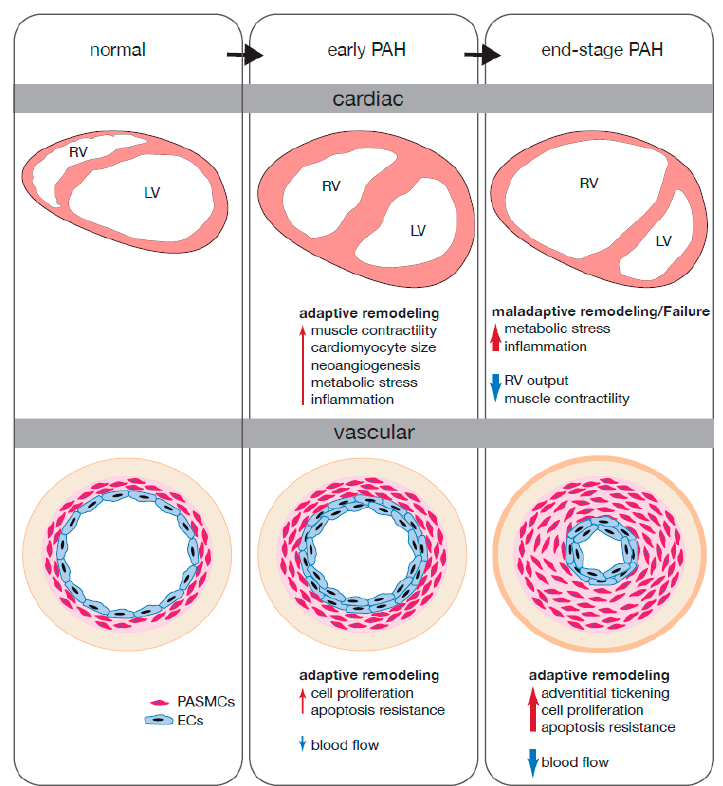
Figure 1. PAH induced pulmonary artery and subsequent RV remodeling and the ncRNAs involved in the process. During PAH, the pulmonary artery undergoes extensive remodeling due to increased proliferation and apoptosis resistance. The number of ECs and PASCMs increases which narrows the artery, decreasing the blood flow and increasing the pressure. Subsequently, the RV undergoes adaptive remodeling to overcome the increased PA pressure; during this adaptive remodeling, contractility, CM size, neoangiogenesis, metabolic stress and inflammation increases. During prolong PAH, the pulmonary artery continues to remodel with continuous proliferation, apoptosis resistance, blood pressure, and adventitial thickening while the blood flow decreases even further. Meanwhile, the RV can no longer sustain its output to overcome the pressure overload leading to a decoupling and maladaptive remodeling. This is marked by an increase in metabolic stress and further